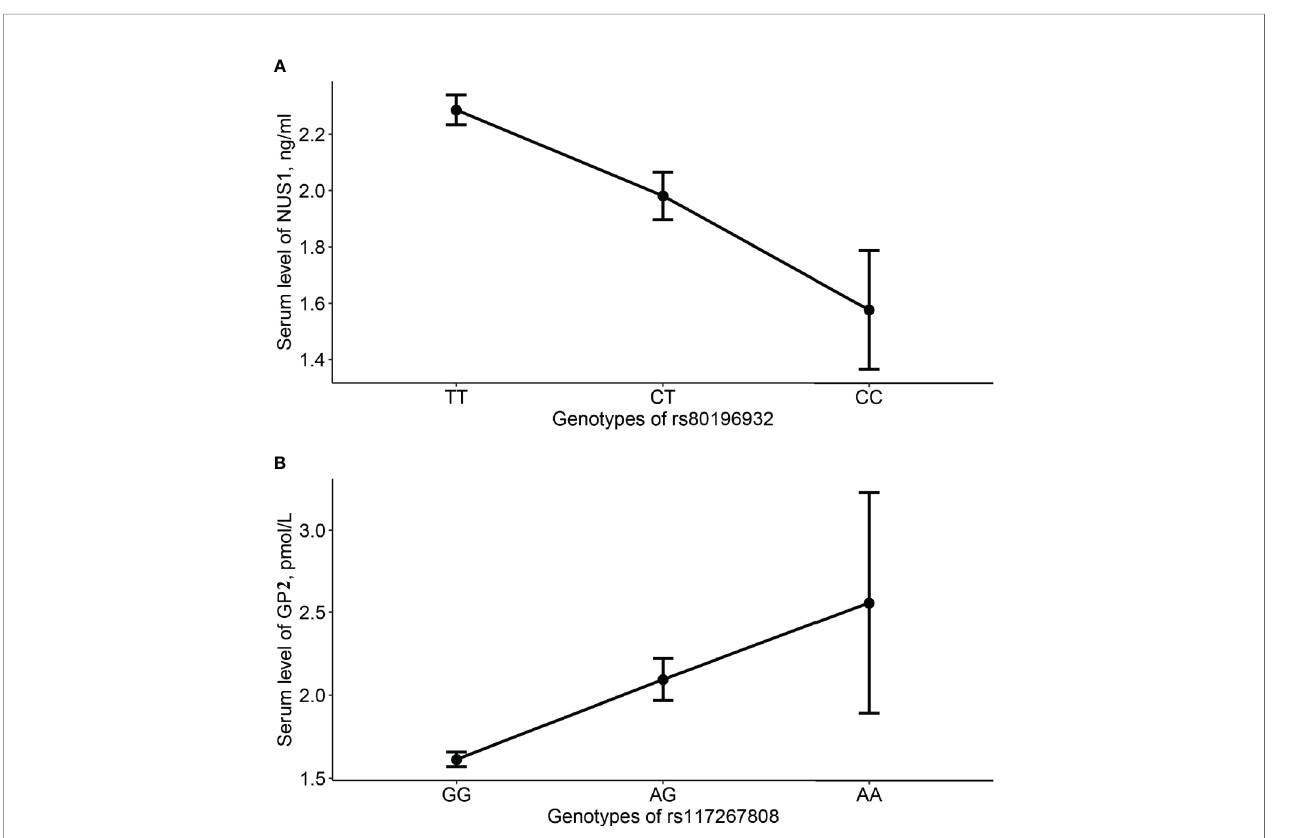
FIGURE 2 | Average serum level of NUS1 andGP2 in different genotypegroups of SNP rs80196932 and rs117267808. (A) Serum level of NUS1 in different genotype groups of SNP rs80196932. (B) Serum level ofGP2 in different genotypegroups of SNP rs117267808. 95% con fi dence intervalswere indicated by the error bars.